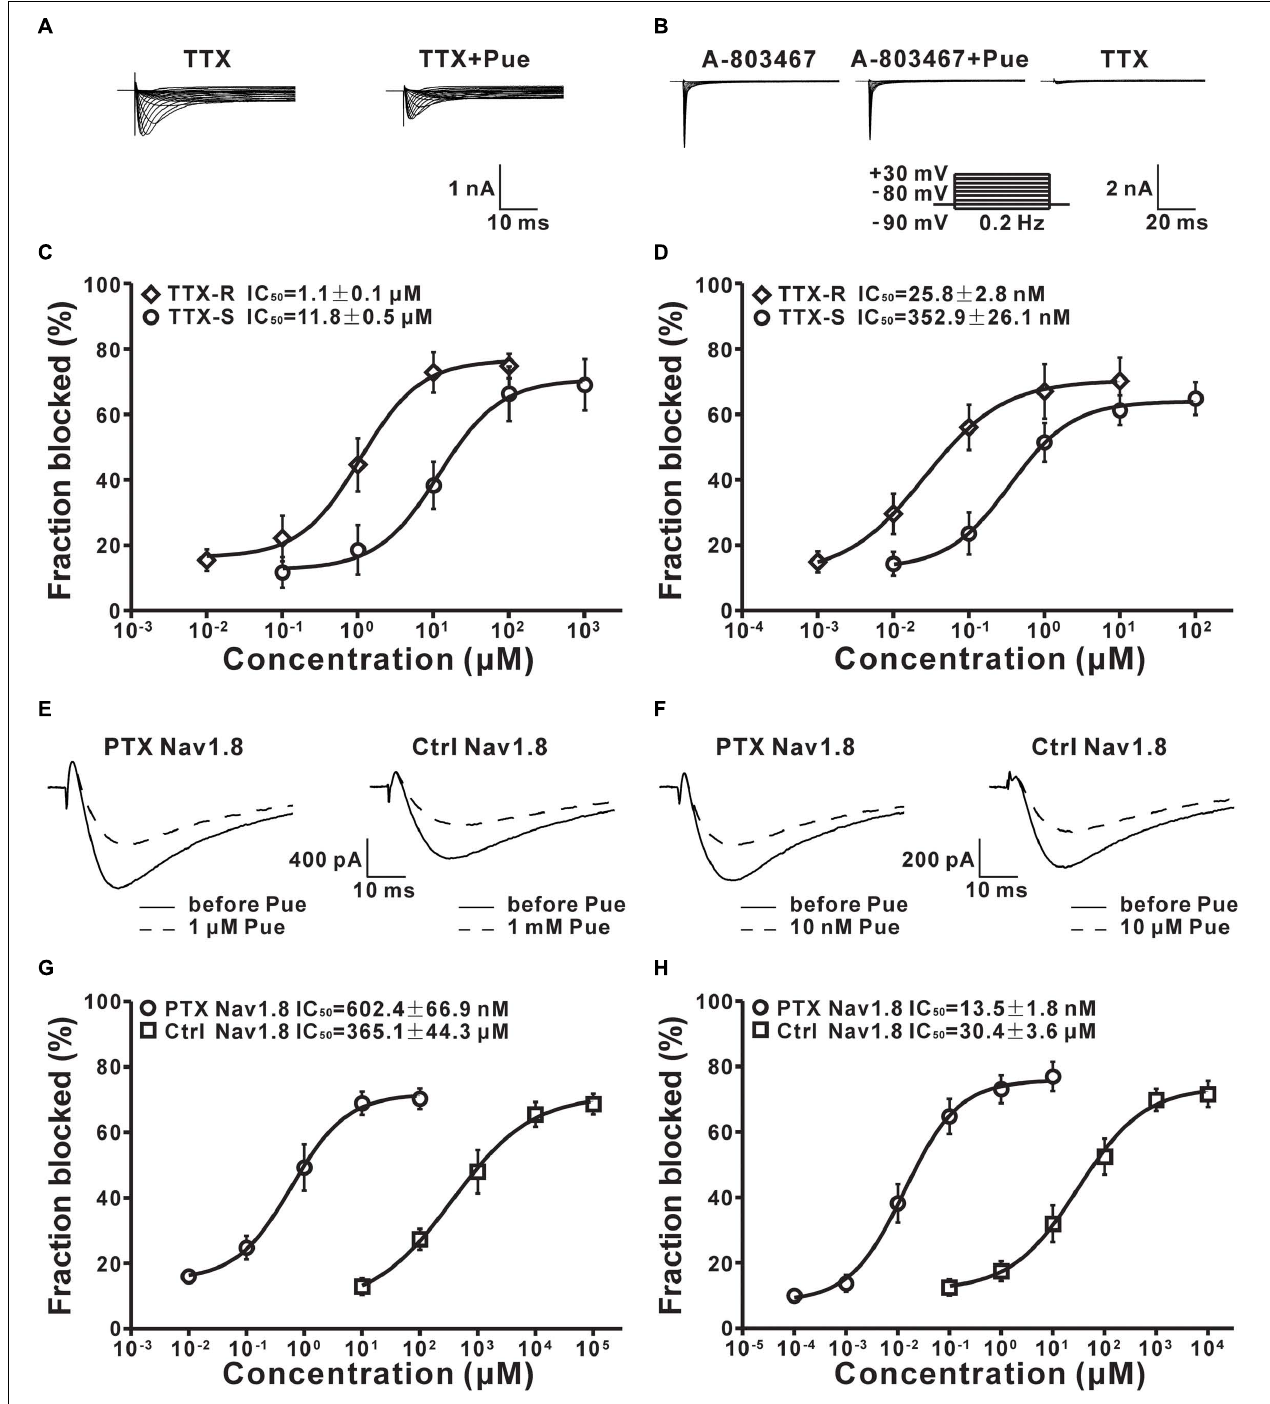
FIGURE 7 | The effect of puerarin on TTX-R, TTX-S and Na v 1.8 channels in DRG neurons (Ctrl, control; PTX, paclitaxel; Pue, puerarin). (A) Representative traces of TTX-R currents recorded in the presence of TTX (300 nM) or TTX (300 nM) and puerarin (0.1 µ M). (B) TTX-S currents were recorded in the presence of A-803467 (1 µ M), A-803467 (1 µ M) and puerarin (0.01 µ M) or TTX (300 nM). (C) IC 50 values of puerarin on resting TTX-R ( n = 10 neurons in each data point) and TTX-S ( n = 9 neurons in each data point) Na v channels in DRG neurons of paclitaxel (day 10) rats. (D) IC 50 values of puerarin on inactivated TTX-R ( n = 9 neurons in each data point) and TTX-S ( n = 9 neurons in each data point) Na v channels in DRG neurons of paclitaxel (day 10) rats. (E) The resting Na v 1.8 current traces were recorded before and 15 min after puerarin application at indicated concentrations. (F) The representative inactivated Na v 1.8 current traces were recorded before and 15 min after puerarin application at indicated concentrations. (G) IC 50 values of puerarin for resting Na v 1.8 in control and paclitaxel (day 10) groups. n = 10 neurons in each data point. (H) IC 50 values of puerarin for inactivated Na v 1.8 in control and paclitaxel (day 10) groups. n = 10 neurons in each data point.